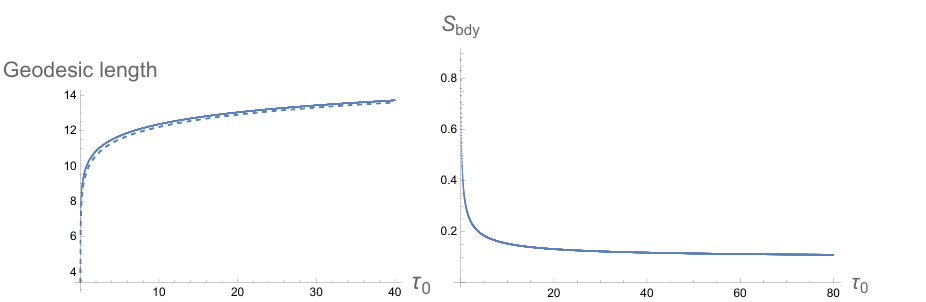
Figure 5 . Left figure shows geodesic length (solid line) of z ( τ ) = τ + τ 2 case and plot of log (2 τ 0 /(cid:15) ) (dashed line). Right figure shows the difference between solid line and dashed line.